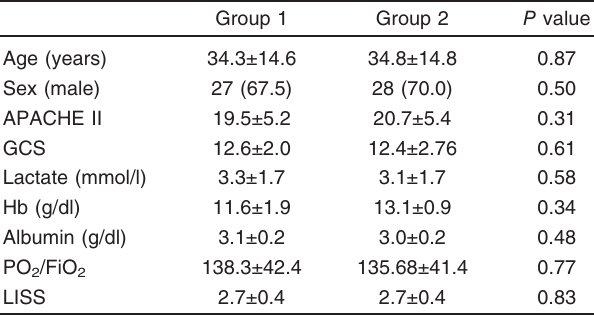
Table 1 General characteristics of the studied